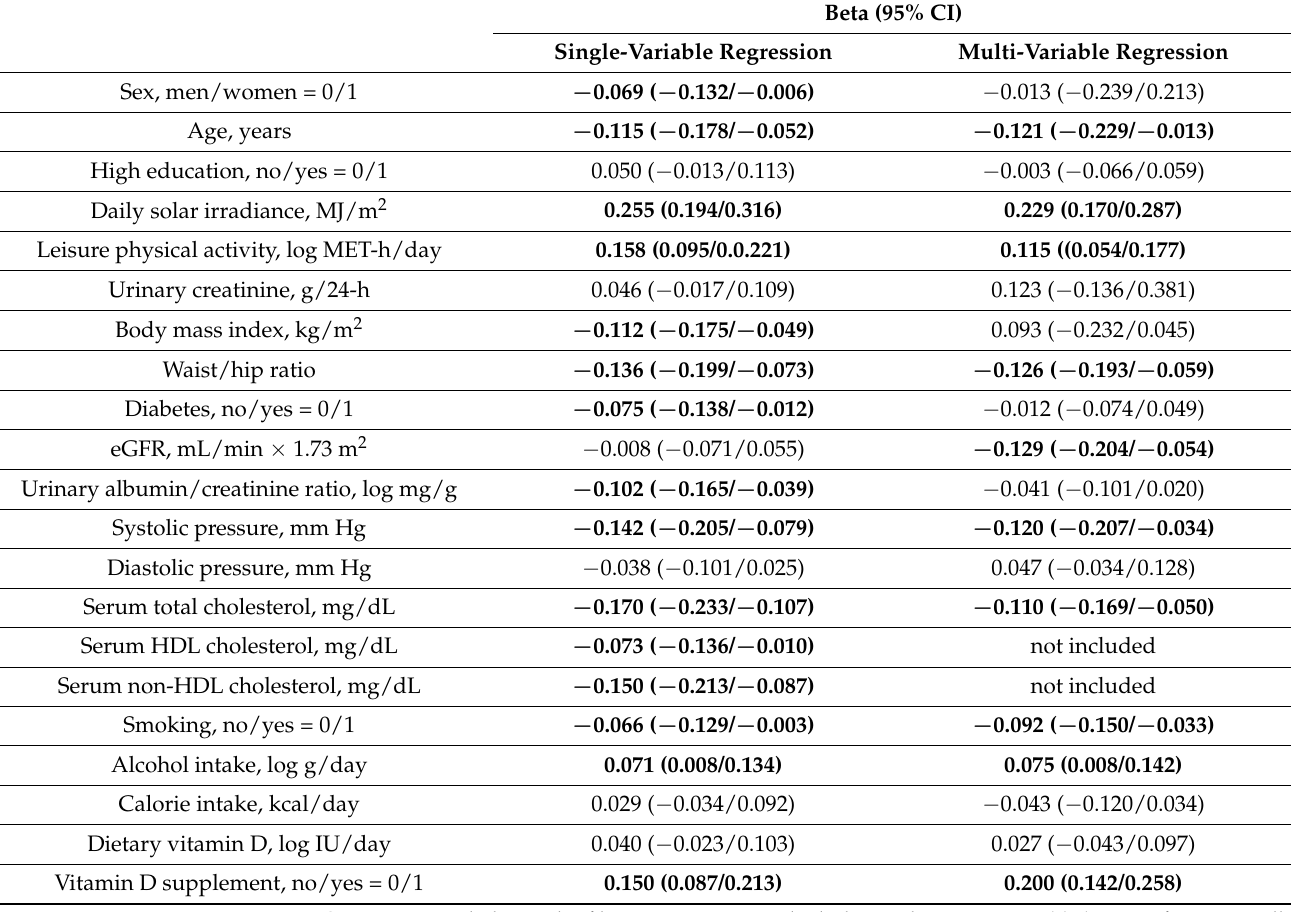
Table 2. Single-variable and multi-variable standardized regression coefficient (beta) to log serum calcidiol as dependent variable. Beta (95% CI) Single-Variable Regression Multi-Variable